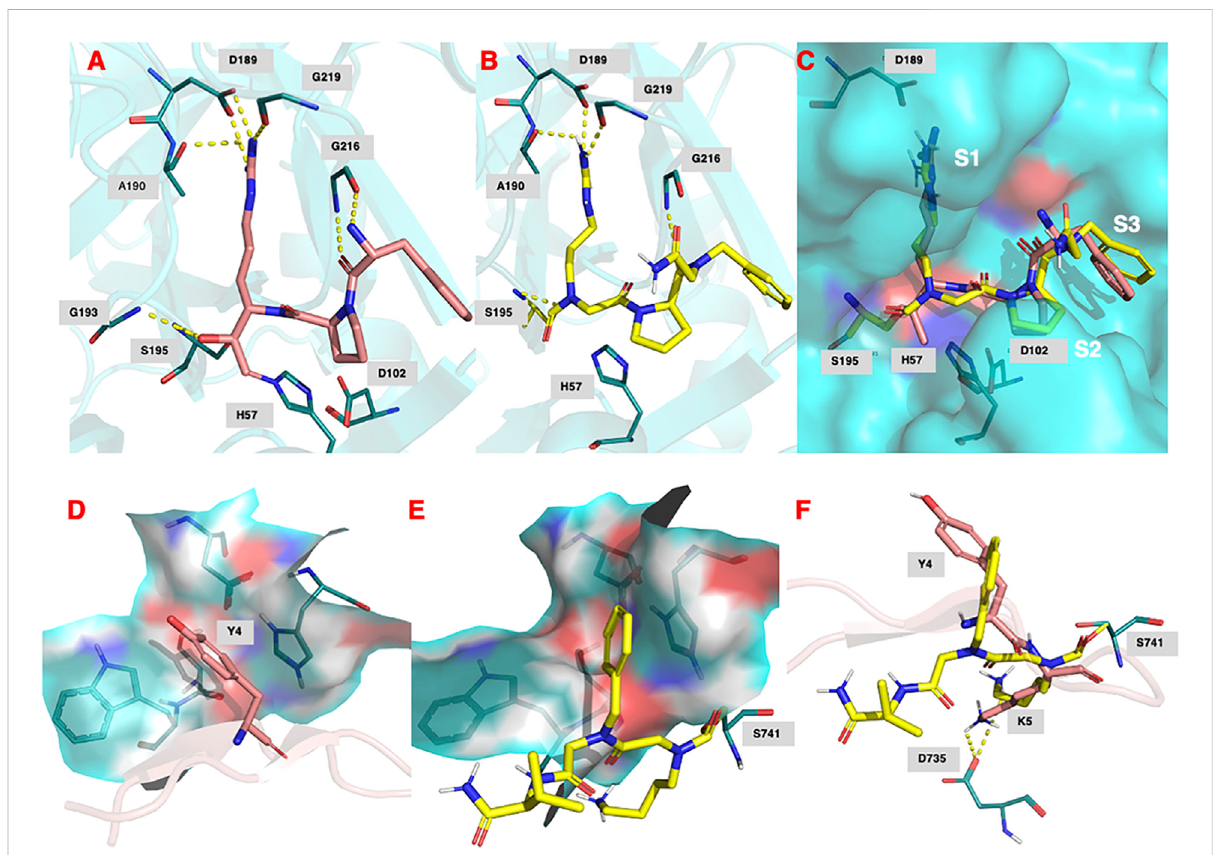
FIGURE 9 (A) Binding of (D)-Phe-Pro-Arg-CH 2 Cl (shown in salmon) within the active site of human thrombin (PDB 1ppb). (B) Predicted docking pose and polarinteractionsofNAP559.NAP559ispredictedtoformanacylenzymewiththeactivesiteserine(S195)ofthrombin. (C) Engagementofthrombin S1, S2 and S3 binding pockets by NAP559 (shown in yellow) and (D)-Phe-Pro-Arg-CH 2 Cl (shown in salmon). (D) Binding of SFTI analogue (shown in salmon) within the active site of plasmin (PDB 6d40) highlighting the S2 binding pocket (residues W761, S760, D646 and H603). (E) Predicted docking pose of NAP533 (shown in yellow) within active site of plasmin (6d40) highlighting the S2 binding pocket. NAP533 is predicted to form an acylenzymewith theactive siteserine (S741 – equivalent toS195 inthrombin). (F) OverlayofNAP530 (showninyellow) andSFTIanalogue (shownin